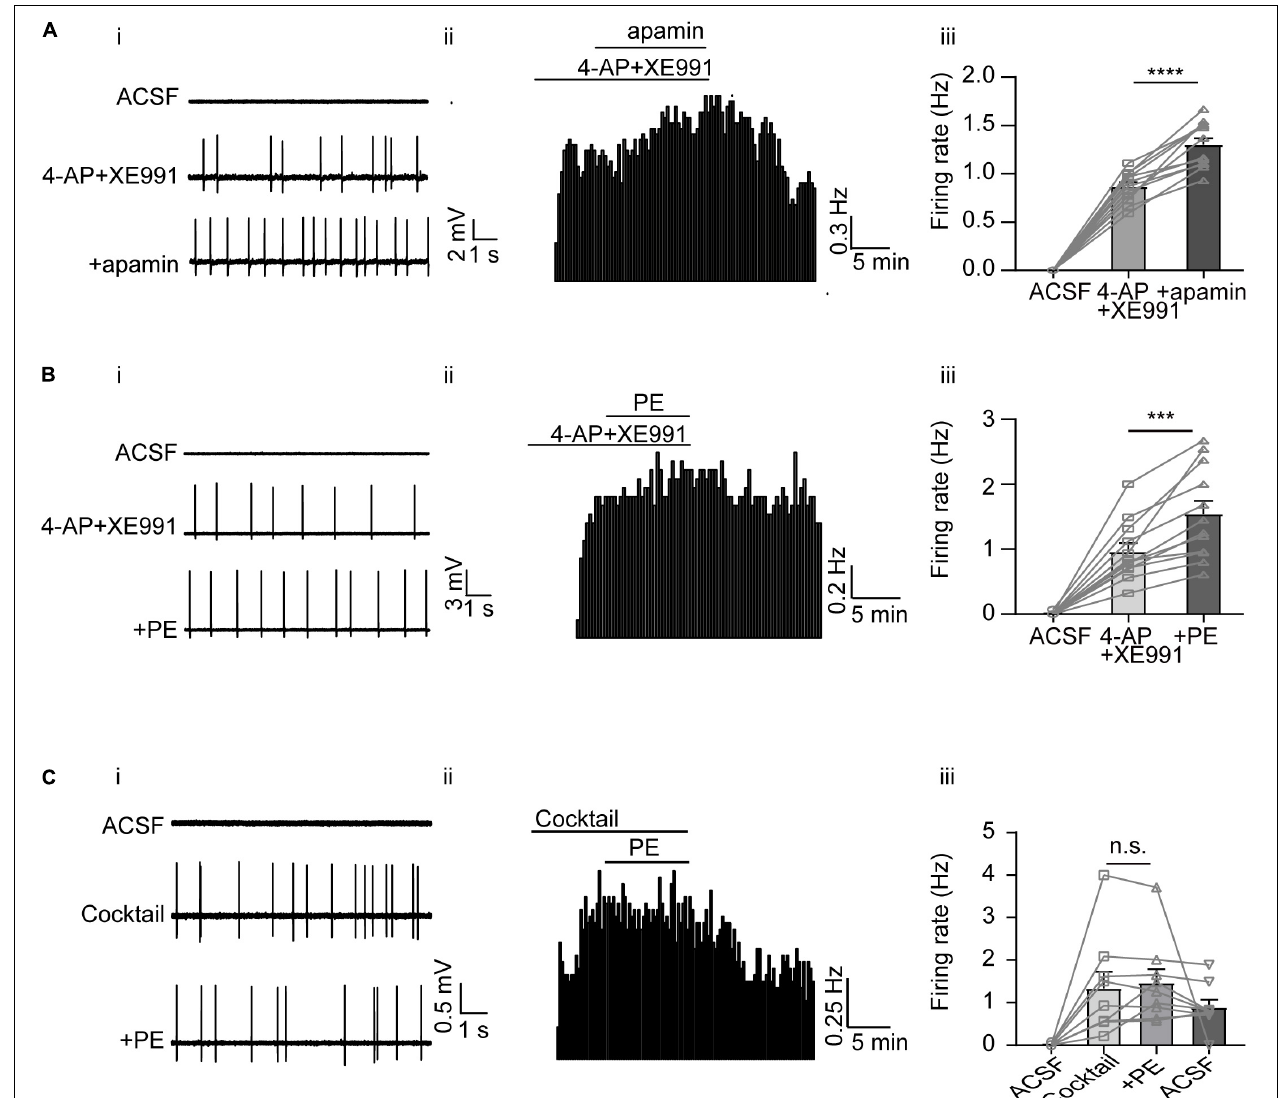
FIGURE 5 | The overall contribution of A-type, M-type, and SK channels to the PE-induced spontaneous firing of the DRN 5-HT neurons. (A) SK channel blocker apamin further increased the induced spontaneous firing of the DRN 5-HT neurons, following the application of 4AP and XE991. (i) Representative traces of action potential spikes recorded using “loose patch” under current-clamp configuration performed on a DRN 5-HT neuron; the effects of 4AP + XE991 and apamin are shown. (ii) Example time course of the spontaneous firing frequency in a 5-HT neuron, under the influence of 4AP + XE991 and apamin. (iii) Summarized effects of 4AP + XE991 and apamin on the spontaneous firing frequency (paired t -test, **** p < 0.0001, n = 12). (B) PE further increased the induced spontaneous firing of 5-HT neurons in the DRN, following the application of 4AP and XE991. (i) Representative traces of action potential spikes recorded using “loose patch” under current-clamp configuration performed on a DRN 5-HT neuron; the effects of 4AP + XE991 and PE are shown. (ii) Example time course of the spontaneous firing frequency in a 5-HT neuron, under the influence of 4AP + XE991 and PE. (iii) Summarized effects of 4AP + XE991 and PE on the spontaneous firing frequency (paired t -test, *** p < 0.001, n = 12). (C) Three K + channel blockers, 4AP, XE991, and apamin, together totally excluded further effect of PE on the spontaneous firing of the DRN 6-HT neurons. (i) Representative traces of action potential spikes recorded using “loose patch” under current-clamp configuration performed on a DRN 5-HT neuron; the effects of cocktail blockers (4-AP, XE991, and apamin) and PE are shown. (ii) Example time course of the spontaneous firing frequency in a 5-HT neuron, under the influence of cocktail blockers and PE. (iii) Summarized effects of cocktail blockers and PE on the spontaneous firing frequency (paired t -test, n . s . p > 0.05, n =